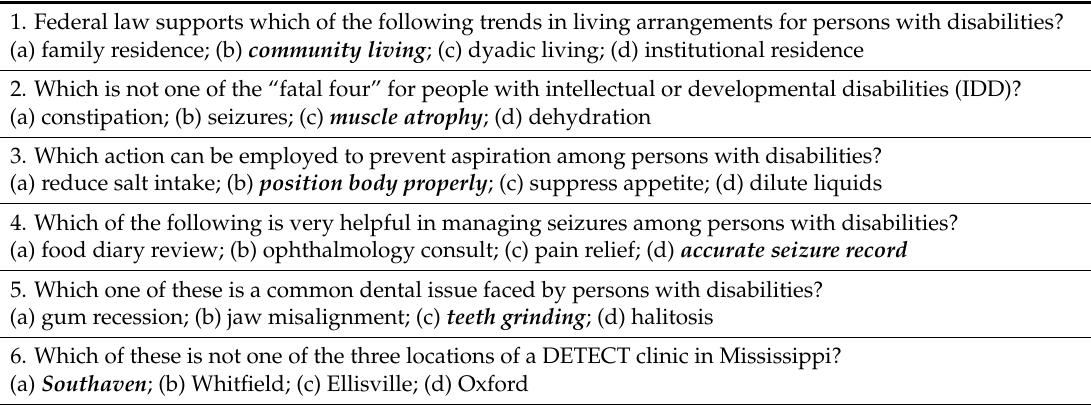
Table 1. Core Measures for Objective Knowledge Quiz Featured on Pretest/Post-Test